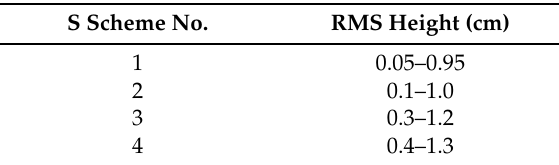
Table 1. Various a priori roughness